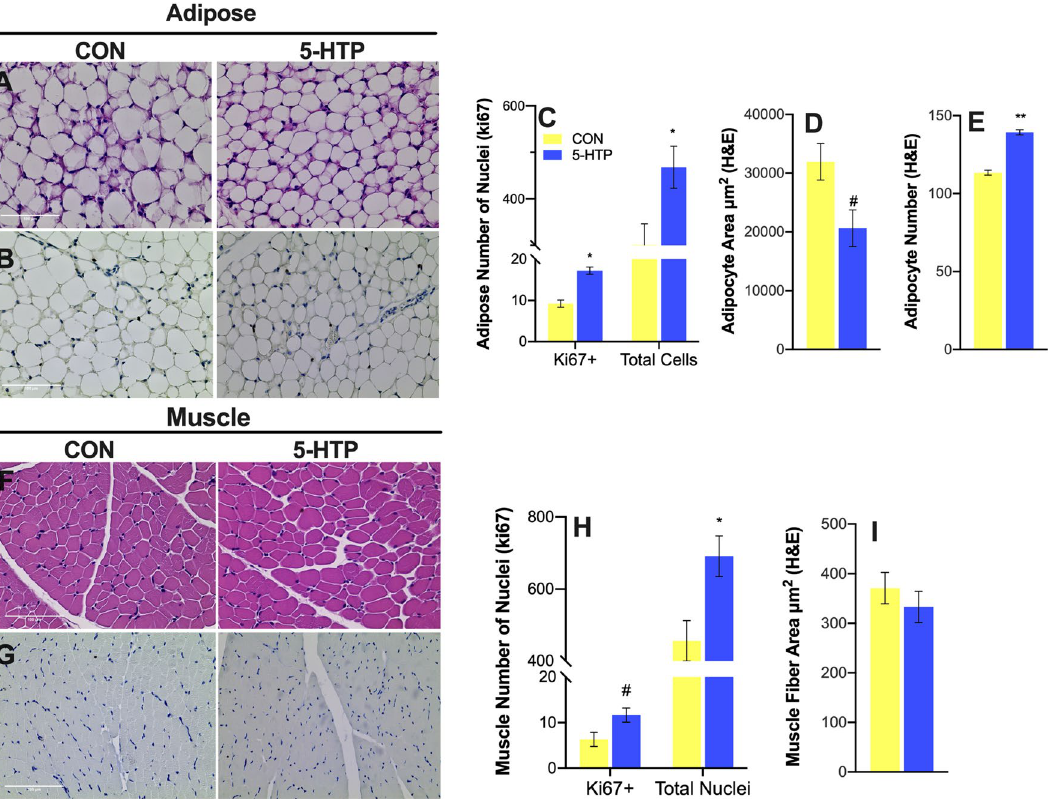
Figure 4. Histological evaluation of subcutaneous WAT and gluteus medius skeletal muscle tissues of pre- weaned dairy calves supplemented 10 days with 5-Hydroxytrytophan (5-HTP, 90 mg/day; n = 4) or saline (CON, 8 mL saline; n = 4). ( A ) Hematoxylin and eosin staining of adipose tissue and ( B) representative immunohistochemical ki67 staining of adipose tissue to quantify ( C ) adipose ki67-positive nuclei and total nuclei, ( D ) adipocyte cross sectional area and ( E ) adipocyte number. ( F ) Hematoxylin and eosin staining of muscle tissue and ( G ) representative immunohistochemical ki67 staining of muscle tissue to quantify ( H ) ki67- positive nuclei and total nuclei and ( I ) muscle fiber cross sectional area. Total tissue area for photomicrographs taken at ×40 is 96,820 µm 2 . Asterisk (*) denotes P ≤ 0.05 and pound sign (#) indicate tendencies 0.05 < P ≤ 0.10 between CON vs 5-HTP treatment